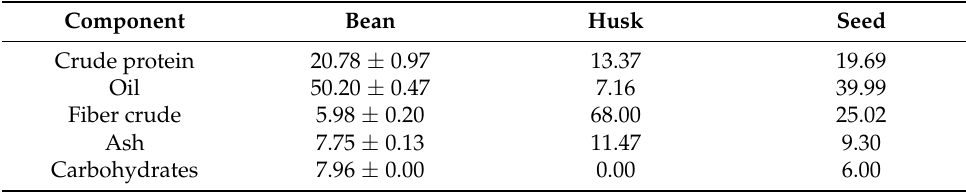
Table 1. Proximal composition of castor seed, castor beans, and castor husks.